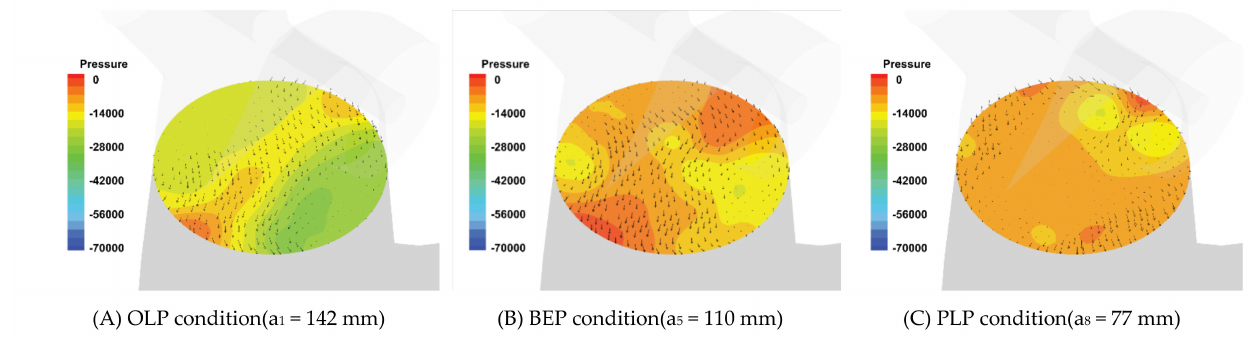
Figure 14. Velocity vector diagram and pressure contour of the inlet section of the draft tube under different working condi-